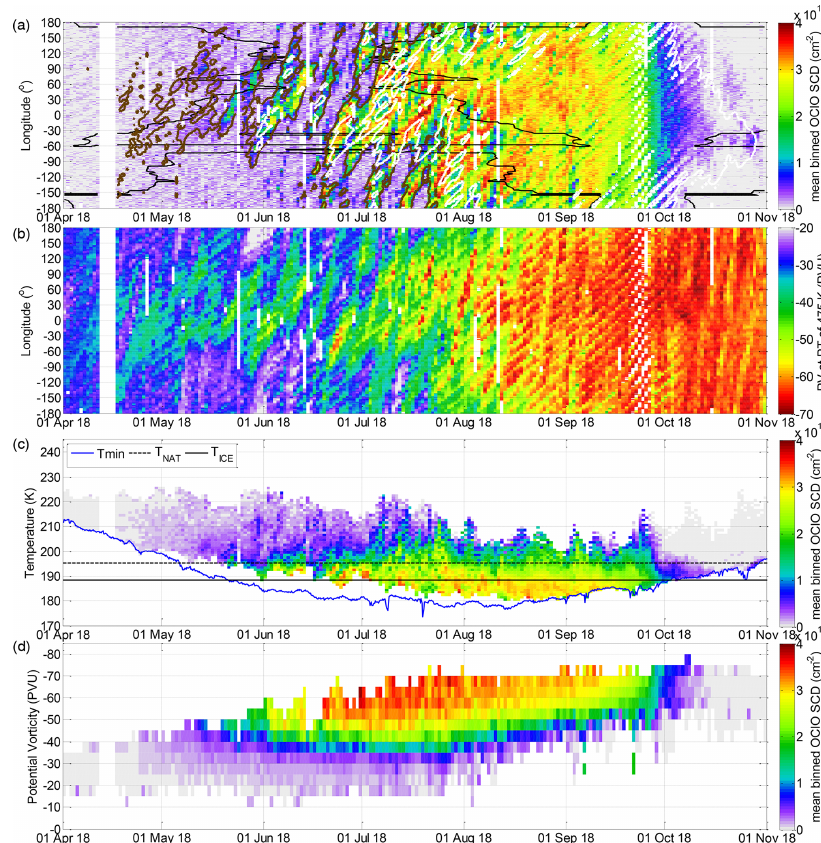
Figure 11. Same as Fig. 2 but for the Antarctic winter 2018, with the brown line in (a) indicating PV = − 35PVU, accordingly.